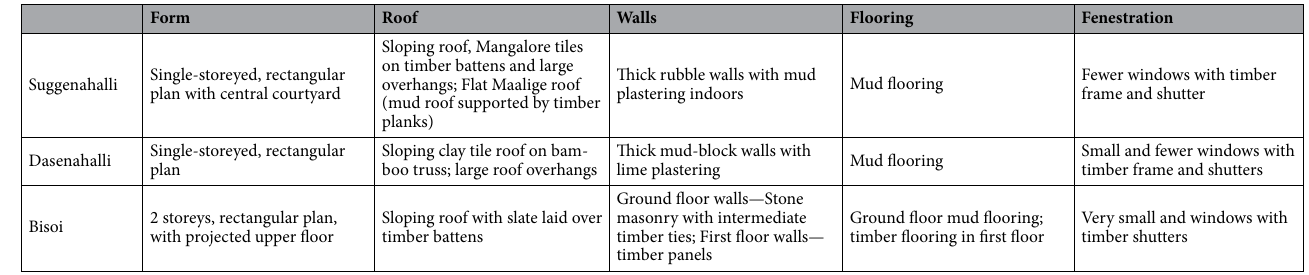
Table 1. Details of the vernacular dwellings in the three